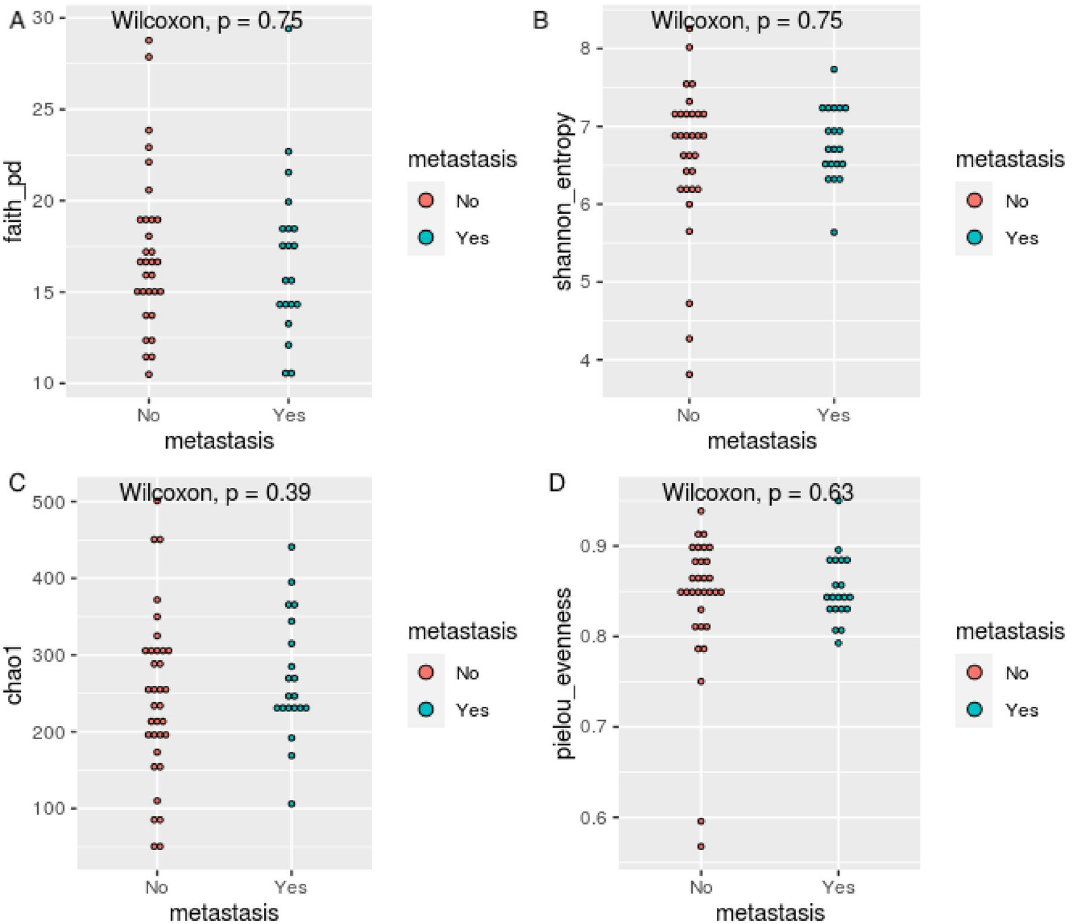
Figure 1. α-diversity in oral squamous cell carcinoma patients with metastasis and no metastasis. The α-diversity in terms of faith_pd ( A ), shannon_entrophy ( B ), chao1, ( C ) and pielou_evenness ( D ) are